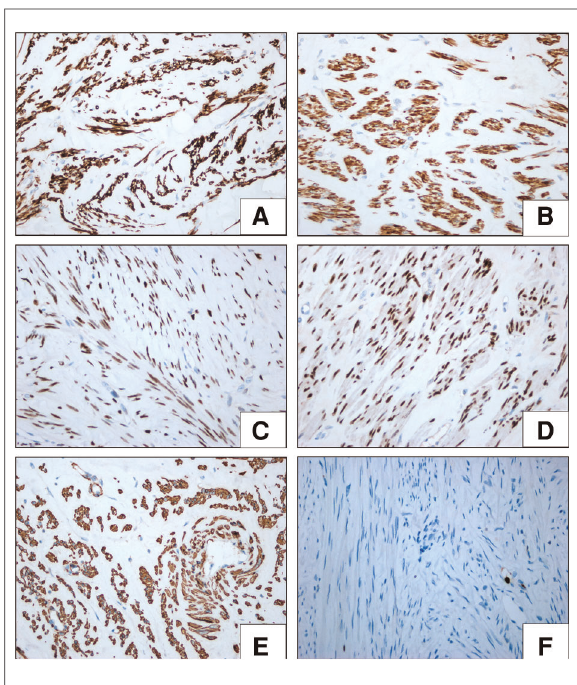
FIGURE 4 Immunohistochemical (IHC) features of metastasizing leiomyoma. (Envision×400) The spindle cells expressed desmin ( A ), caldesmon ( B ), PR ( C ), ER ( D ) and SMA ( E ). The calculated Ki67 labeling index was less than approximately 2% ( F ).